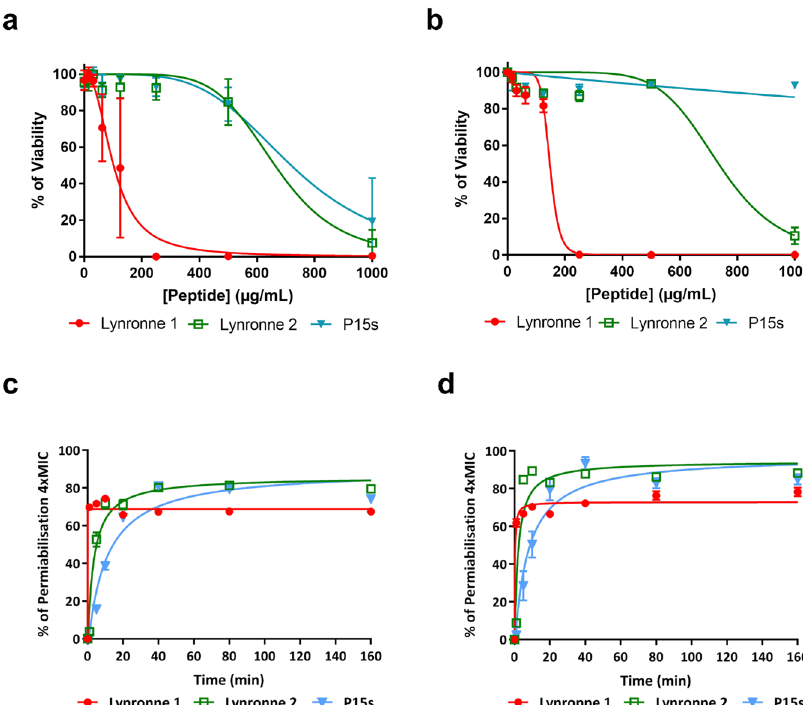
Fig. 2 AMPs cytotoxicity and membrane permeabilisation. a Cytotoxicity of Lynronne 1, 2 and P15s against human cell lung cells IMR90 (human bronchial fi broblasts). b Cytotoxicity of Lynronne 1, 2 and P15s against BEAS-2B (human lung epithelial cells). In all cases, values are from three independent replicates; results are expressed as means ± standard deviation. c AMP membrane permeabilisation activity at 4× MIC against PAO1 measured by propidium iodide method over time ( d ) AMP membrane permeabilisation activity at 4× MIC against LES431 measured by propidium iodide method over time. In both cases, values are from three independent replicates; results are expressed as means ± standard deviation (when not visible, this is due to lack of